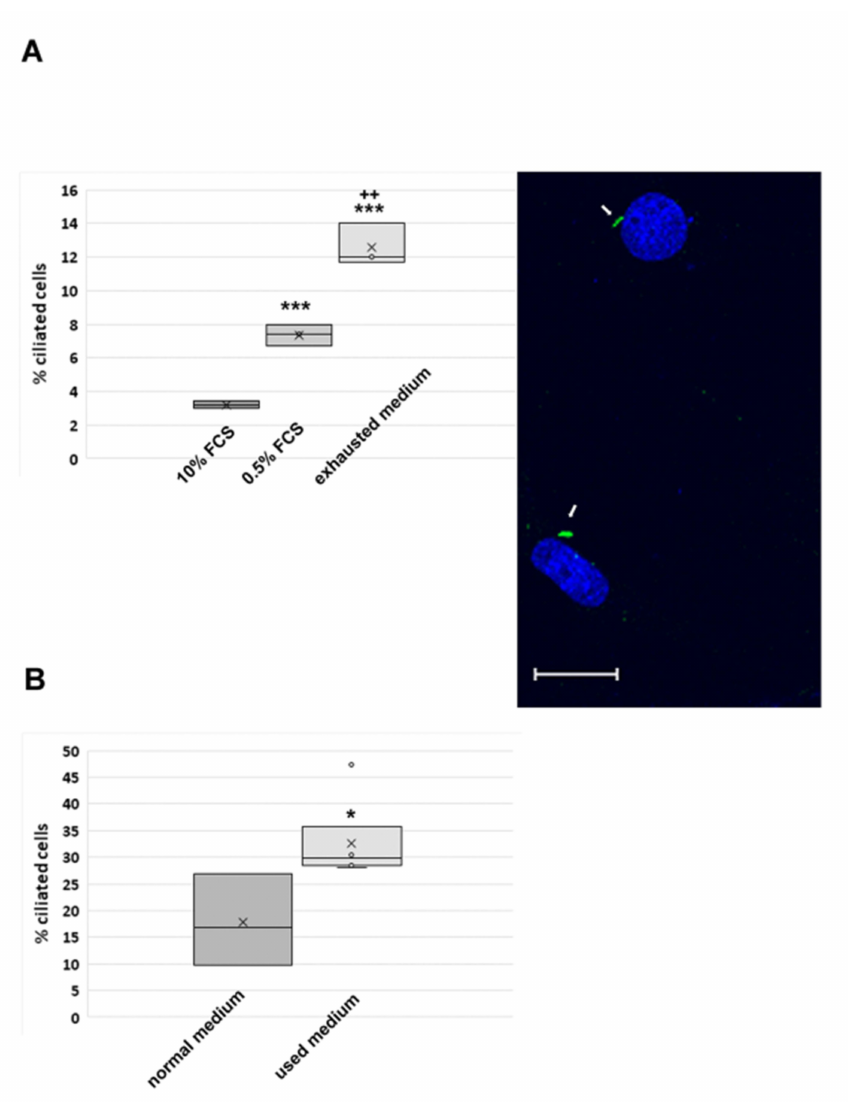
Figure 1. Induction of primary cilia in NIH3T3 cells by cultivation in the serum starved or exhausted (used) medium. ( A ) NIH3T3 cells (charge I) were seeded at a density of 2 × 10 5 cells per 6-well